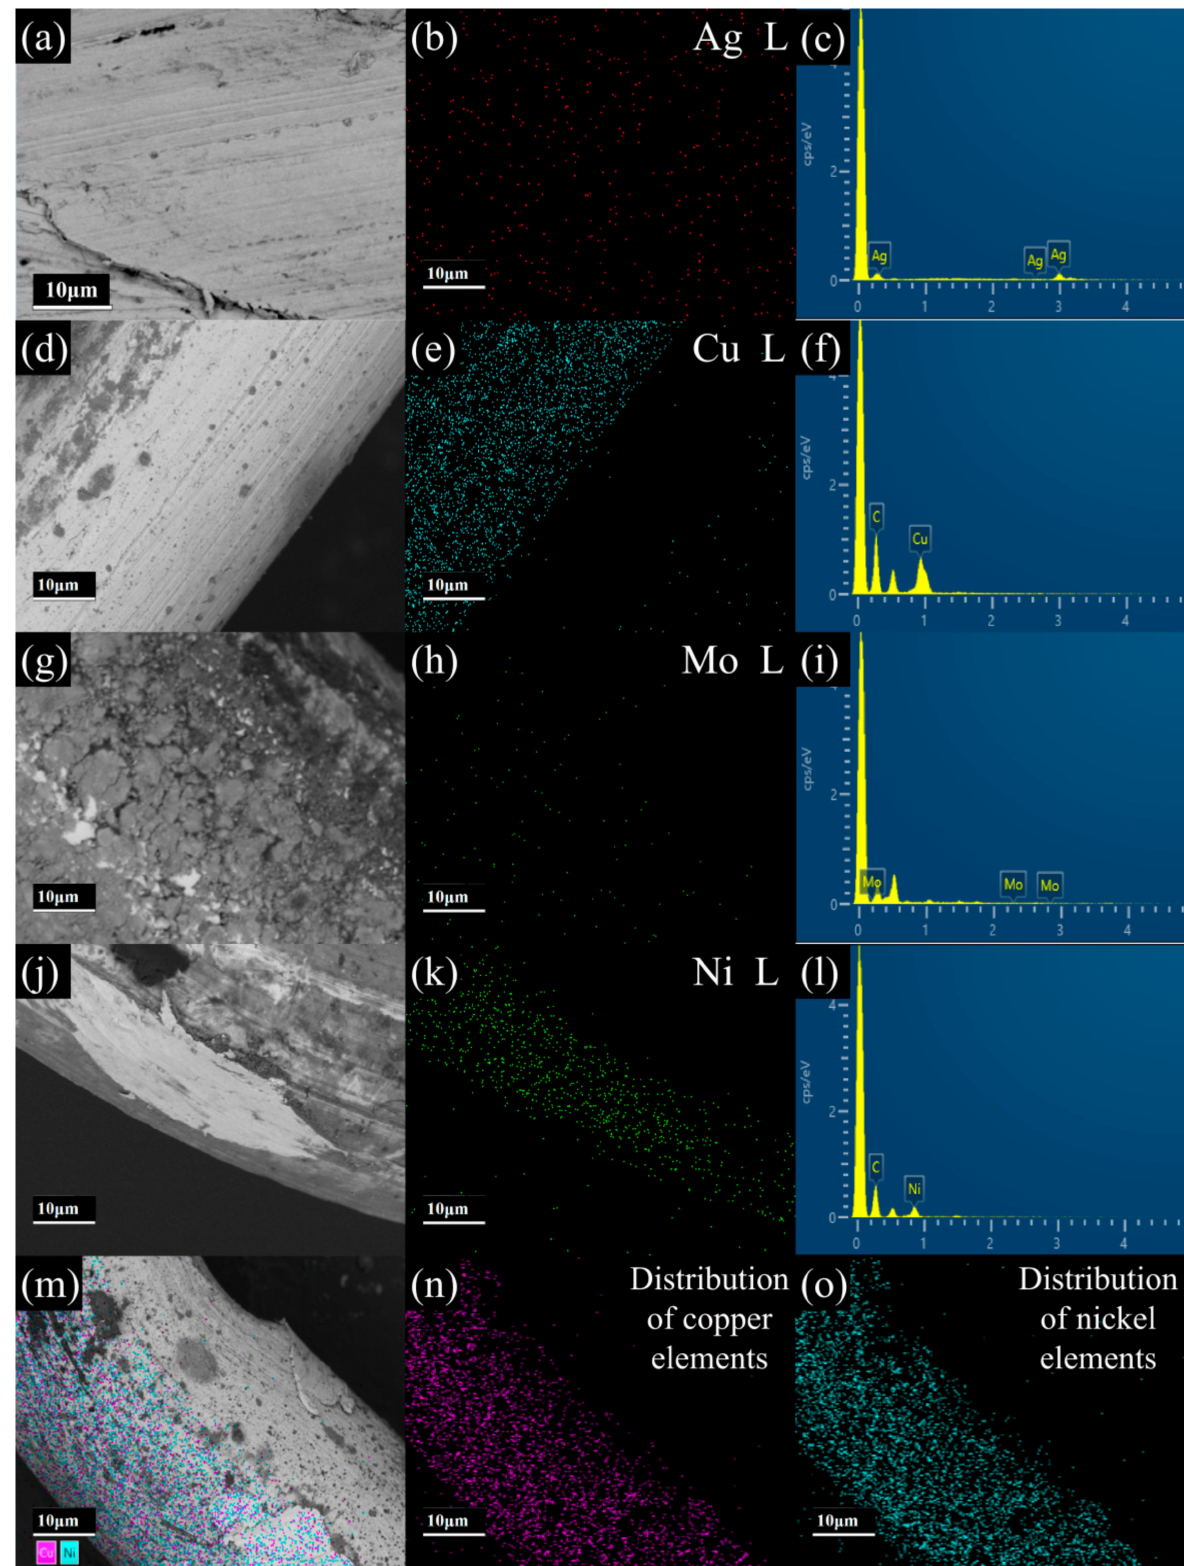
Figure 5. ( a – o ) Different metal mesh SEM image, mapping, and EDX